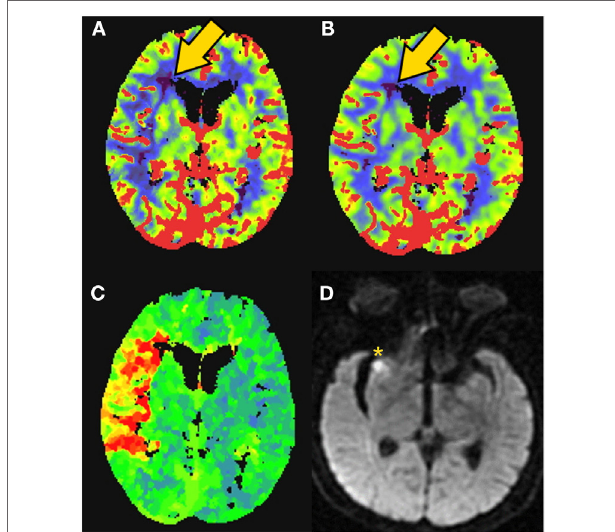
FigURe 5 | CT perfusion to identify salvageable tissue. 81-year-old female with right middle cerebral artery (MCA) syndrome and occlusion of the MCA on CT-angiogram. CT-perfusion maps: (A) cerebral blood flow (CBF), (B) cerebral blood volume (CBV), and (C) time to peak (TTP). Elevated time-to-peak contrast enhancement (TTP) colors orange to red represent > 6- s delay (C) . Severely low blood flow and volume territories are violet color (gold arrow). The patient was rapidly revascularized and the final infarction is demonstrated on MRI diffusion weighted imaging [ (D) ––yellow asterisk]. Data analysis for figure was created under approval of local ethics